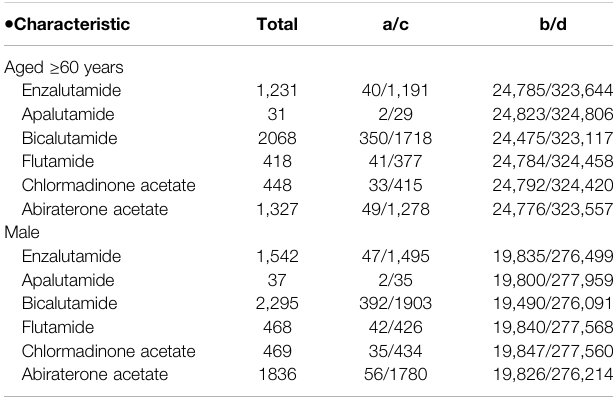
a Represents cases that belong to the group identi fi ed as ILD. b Represents cases that did not belong to the group but were identi fi ed as ILD. c Represents cases that belong to the group and were not identi fi ed as ILD. d Represents cases that did not belong to the group and were not identi fi ed as ILD.